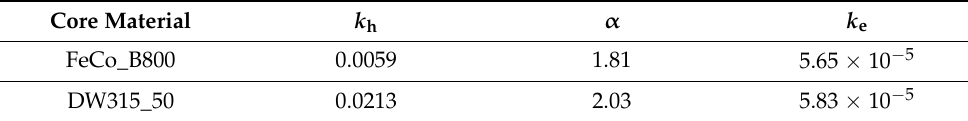
Figure 10. Current waveform and harmonic components. Table 2. Loss factor of stator core